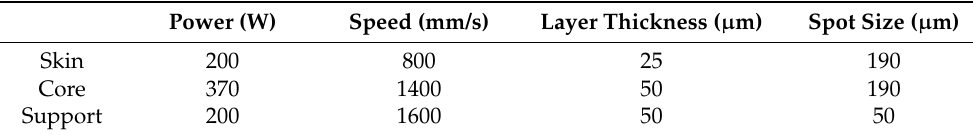
Table 2. Printing parameters used for AlSi10Mg L-PBF samples. Power (W) Speed (mm/s) Layer Thickness ( µ m) Spot Size ( µ m) Skin 200 800 25 190 Core 370 1400 50 190 Support 200 1600 50 50